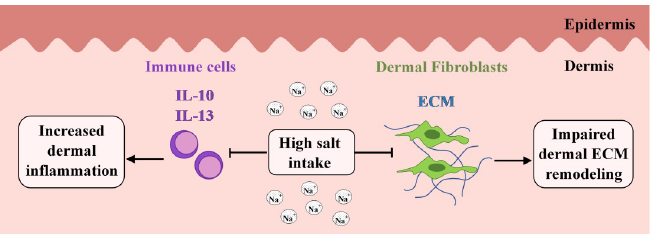
Fig 6. Schematic representation of how high salt diet may mediate inflammation and ECM remodeling in the skin. Our results showed that high salt loading and the consequently increased dermal sodium (Na + ) content reduced the anti-inflammatory IL-10 and IL-13 cytokine expression of immune cells in the skin, even in dermatitis. These findings suggest the role of high salt diet in dermal inflammation. Furthermore, our results revealed the inhibitory effect of high salt loading on the ECM production of dermal fibroblast which can lead to impaired dermal ECM remodeling.